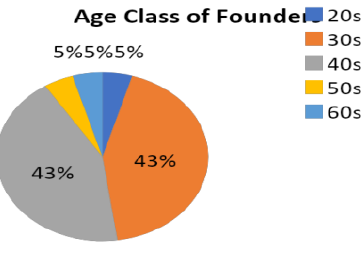
Figure 3: Age of Startup Founders